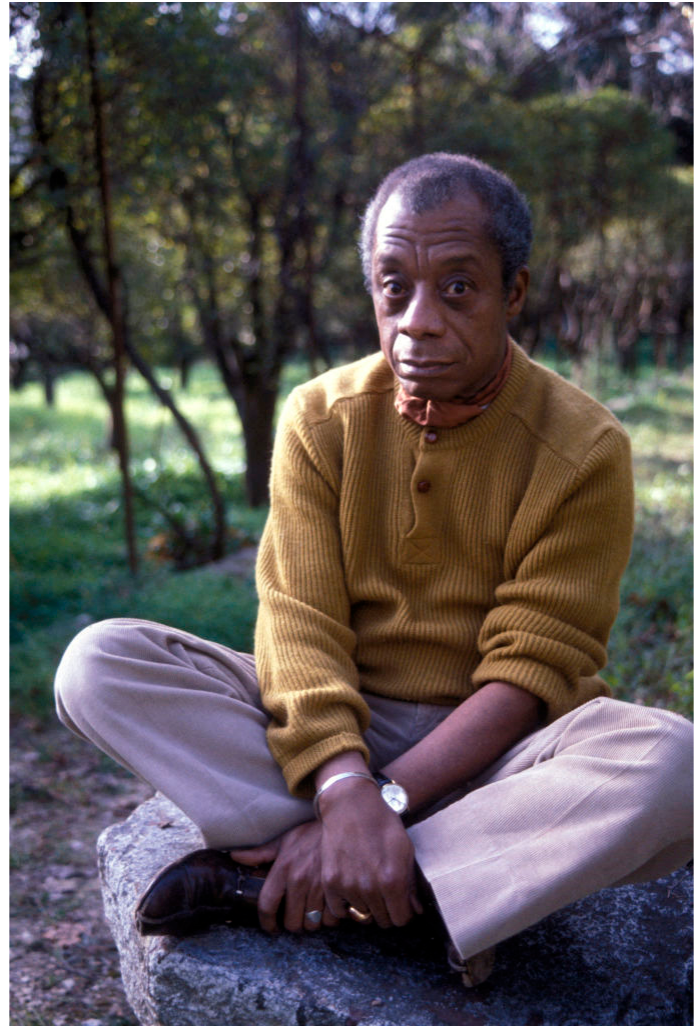
Figure 4. Photo by Micheline PELLETIER/Gamma-Rapho via Getty Images.